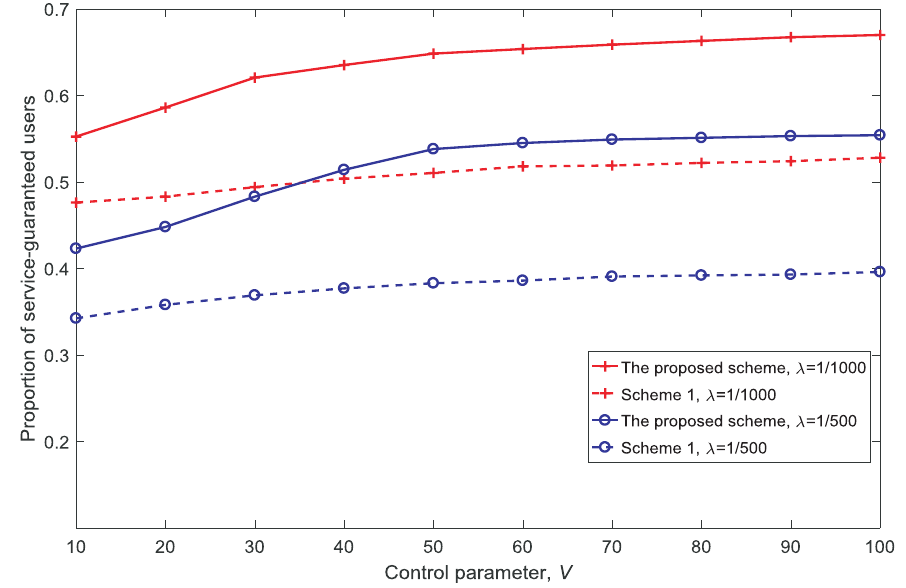
Figure 7. Proportion of service-guaranteed users for different control parameter values V ( d V = 10, K = 3, N = 5 )